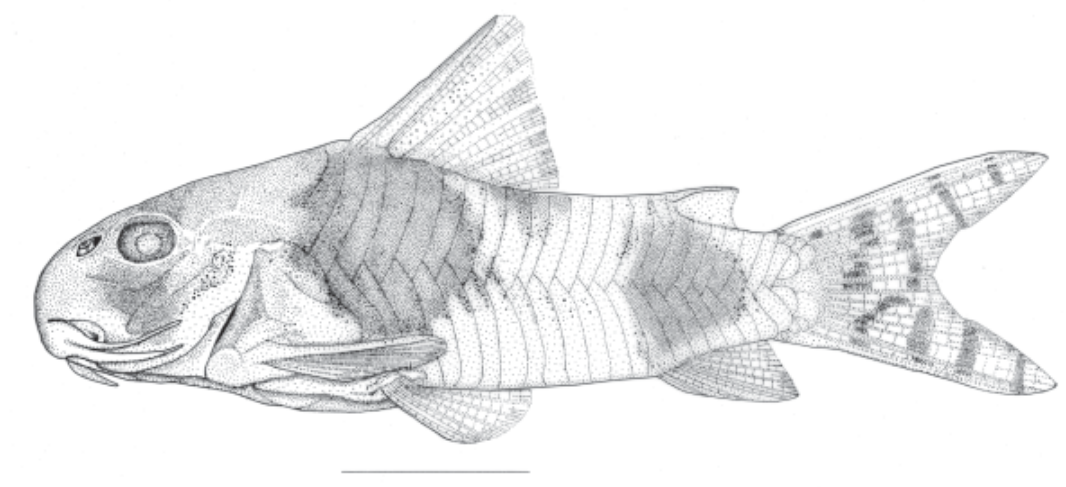
Fig. 1. Corydoras tukano , holotype, MZUSP 82100, presumably a female, 40.9 mm SL; Brazil, Amazonas state, rio Tiquié, comunidade de Caruru. Caudal-fin margin reconstructed from MZUSP 81194, 37.4 mm